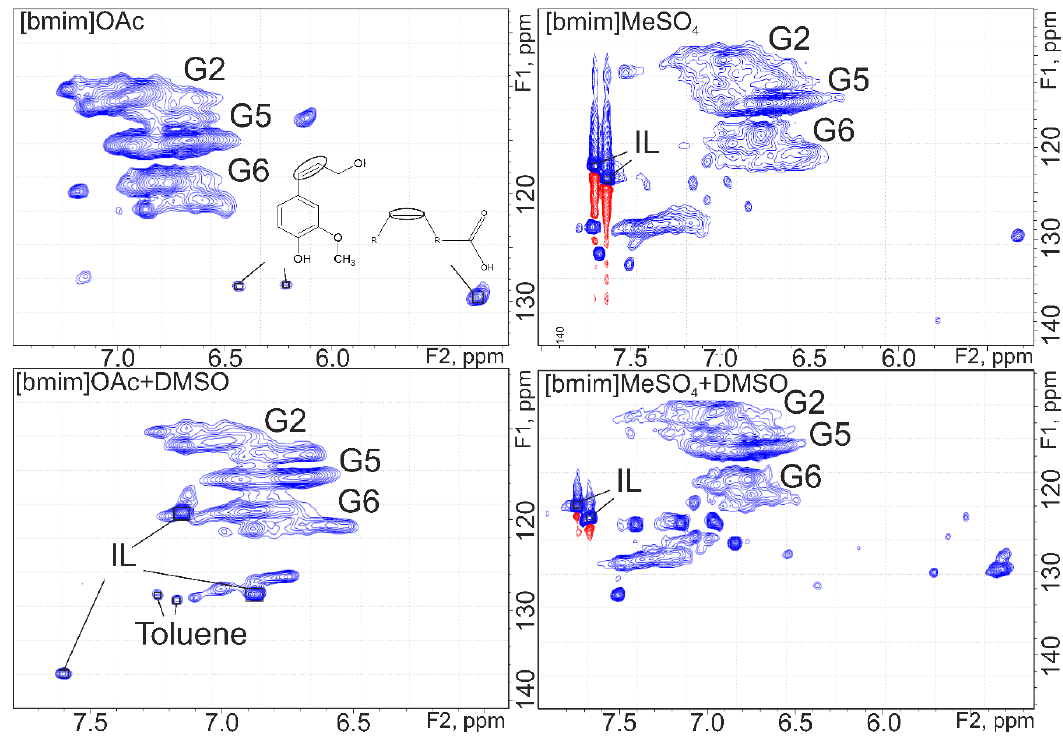
Figure 2. 2D NMR spectra (HSQC) of IL lignins (aromatic structures region).